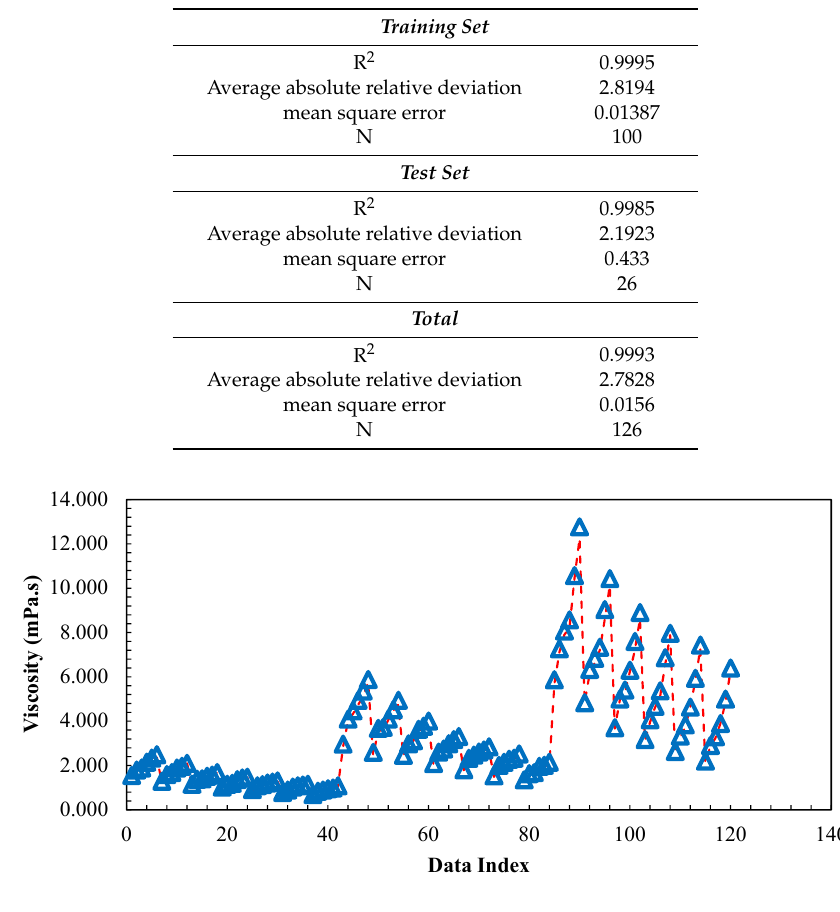
Figure 6. Regression plot of the proposed vector machine model versus actual viscosity of /ethlyene glycol-water nanofluid. Table 3. Statistical parameters of the evolved LSSVM approach for determination of viscosity of Fe 2 O 3 /ethylene glycol-water nanofluid.